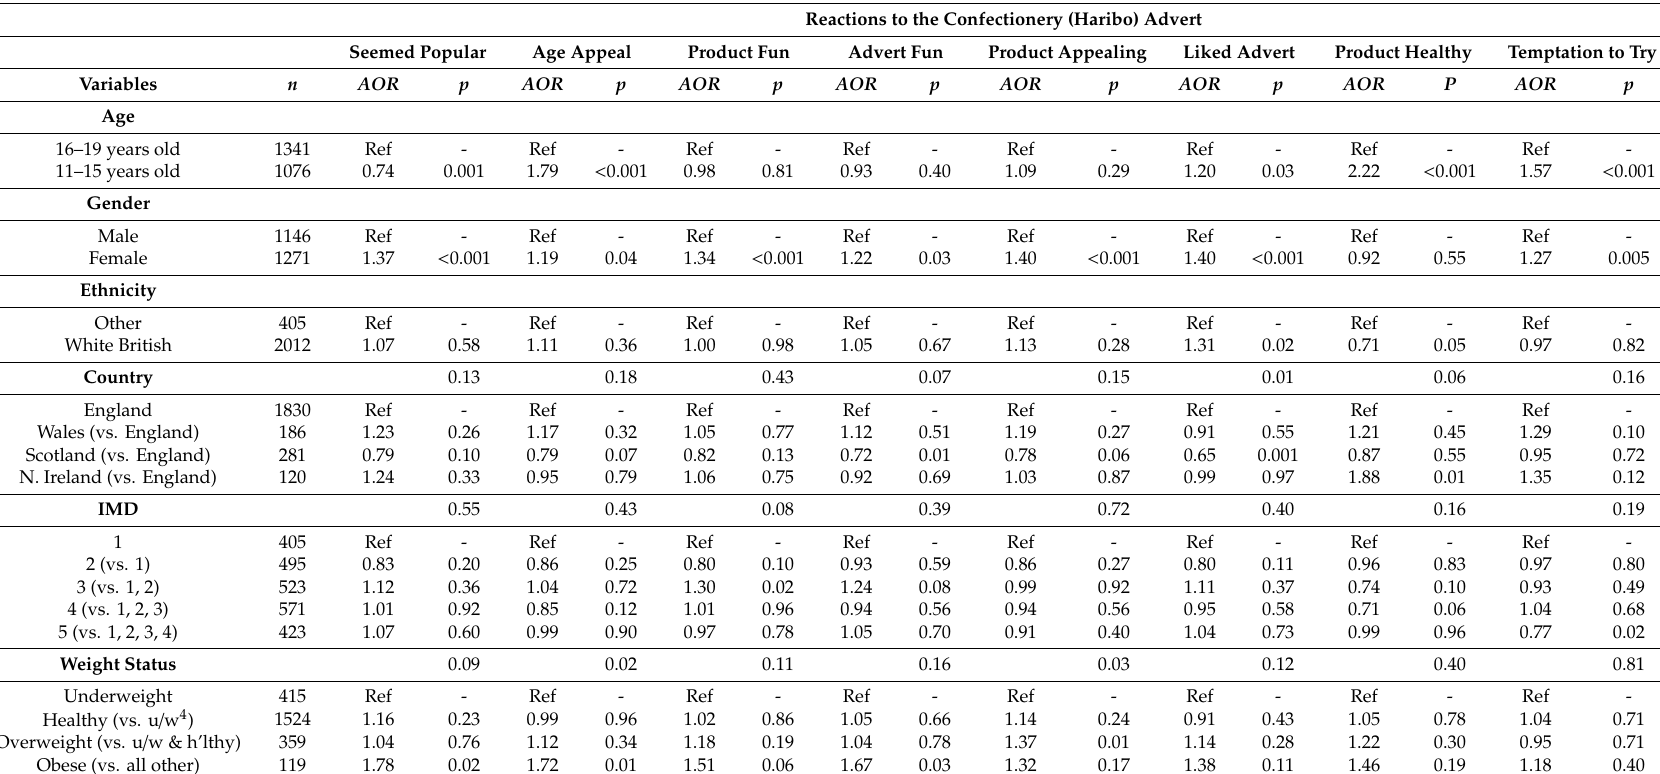
Table 5. Reactions to the confectionery (Haribo) advert and associations with demography and the BMI